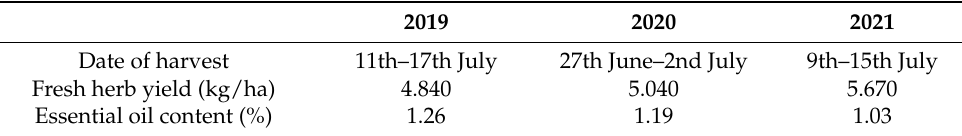
Table 2. Date of harvest, fresh herb yield and essential oil content for L. x intermedia cv. ‘Budrovka’ cultivated in Fruška gora Mt. during 2019–2021.